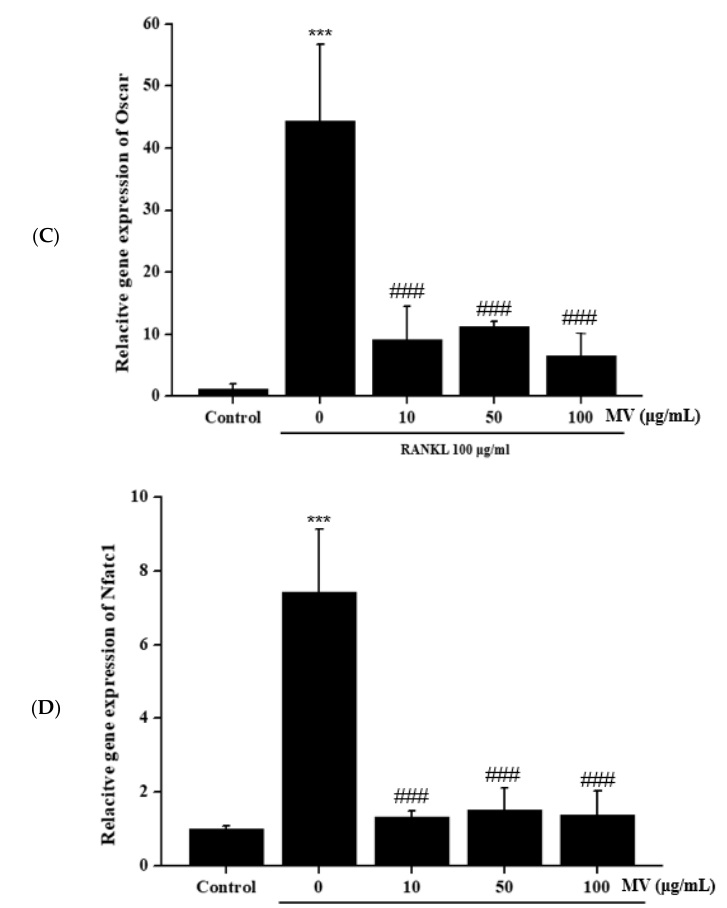
Figure 4. Osteoclastogenesis-related gene expression in RANKL-induced Raw264.7 cells administered with different dosages of dried mulberry vinegar for five days; ( A ) Relative gene expression of Acp5 (TRAP) ; ( B ) Relative gene expression of CtsK ; ( C ) Relative gene expression of Oscar ; ( D ) Relative gene expression of NFATc1 ; Bars and error bars represented mean±standard deviation ( n = 5). * Significantly different from the Control at p < 0.05, ** at p < 0.01, and *** at p < 0.001. # Significantly different from the 0 μ g/mL MV treatment at p < 0.05, ## at p < 0.01, ### at p < 0.001. + Significantly different from 10 ng/mL MV treatment at p < 0.05.